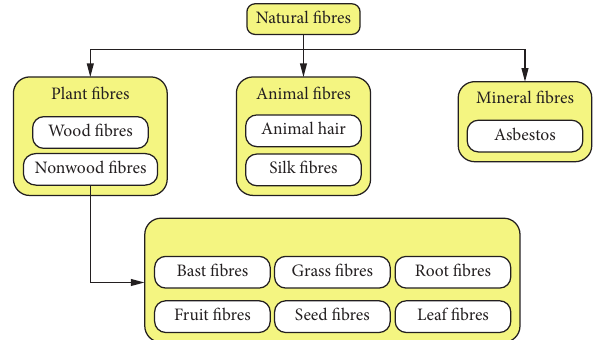
Figure 1: Classification of natural fibres